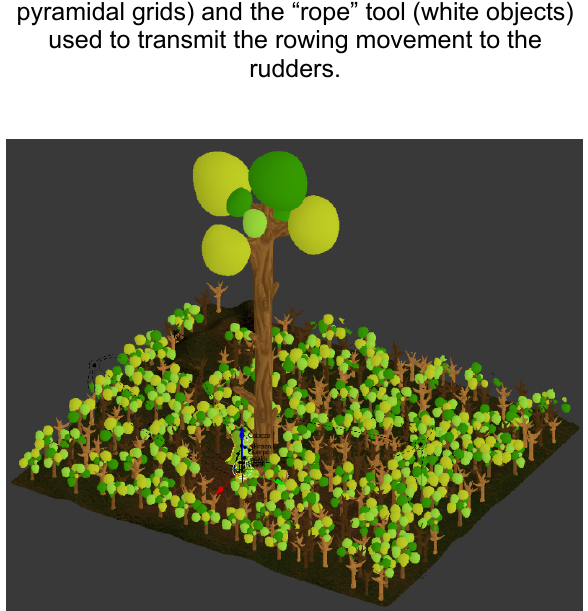
Fig. 11: Tree model showing a different configuration of the